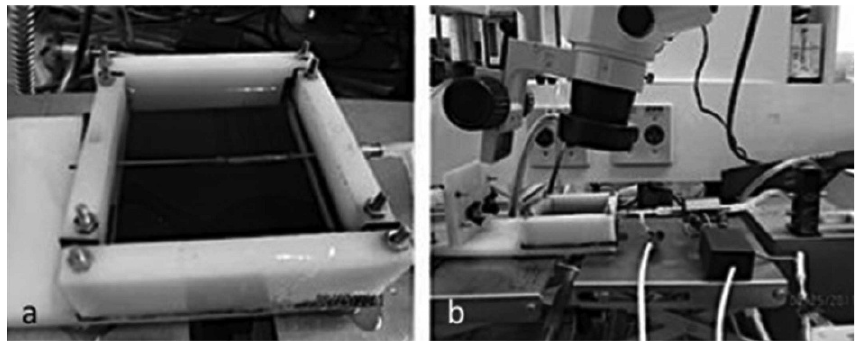
Figure 1 - Environment used for the measurement of airway respiratory mechanics using image processing. (a) Trachea immersed in Krebs-Henseleit solution in an open-top polyurethane conditioner. (b) Overview of the stereomicroscope, airway conditioner, pressure transducers, Fleisch pneumotachograph, and